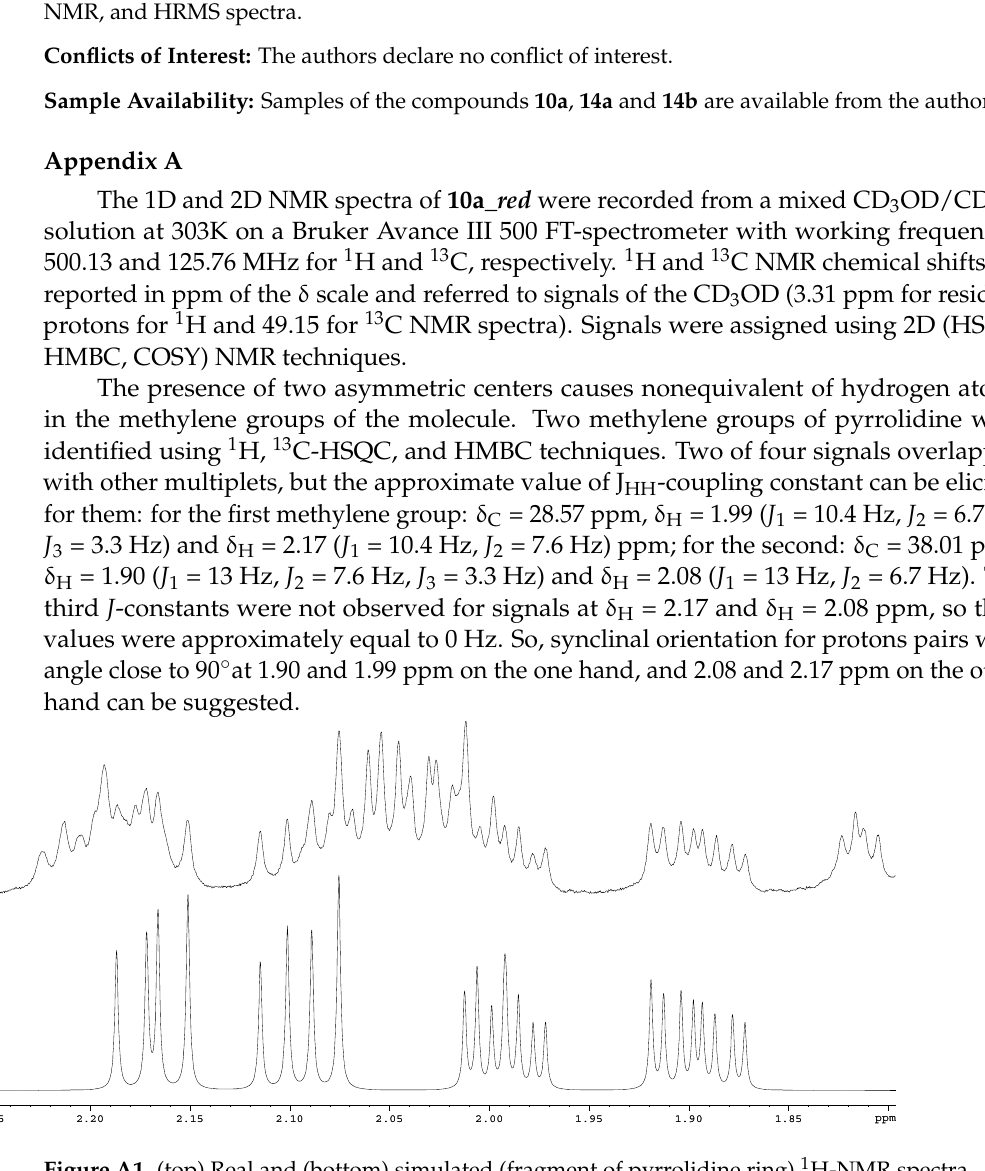
Figure A2. Assignment of signals of 13 C-NMR (black) and 1 H NMR (blue) for 10a_ red . Slashed red lines show through-space interactions in 1 H, 1 H–NOESY spectrum. References 1. Ouari, O.; Gigmes, D. Nitroxides: Synthesis, Properties and Applications ; Royal Society of Chemistry: London, UK, 2021. ISBN 978-1-78801-752-7. https://doi.org/10.1039/9781788019651-00007. 2. Kokorin, A.I. (Ed.) Nitroxides—Theory, Experiment and Applications ; IntechOpen: London, UK, 2012. ISBN 978-9535107224. 3. Likhtenshtein, G.I.; Yamauchi, J.; Nakatsuji, S.; Smirnov, A.; Tamura, R. Nitroxides. Applications in Chemistry, Biomedicine and Material Science ;